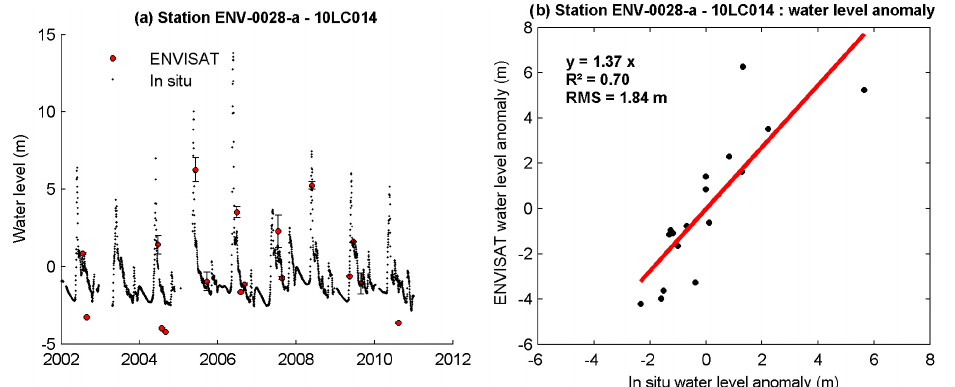
Figure 8. Altimetry-based water levels from 2002 to 2010 compared to in situ water levels for the station 0439-a located in the centre of the Mackenzie Delta (a) using ENVISAT mission and (b) water level anomaly with statistic